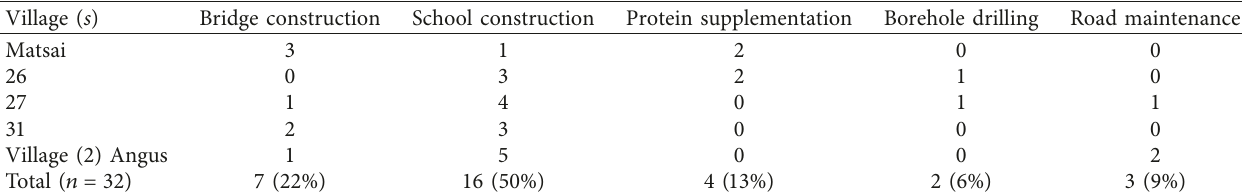
Table 1: Responses toward the nature of benefits derived from SVC across the villages. Village ( s